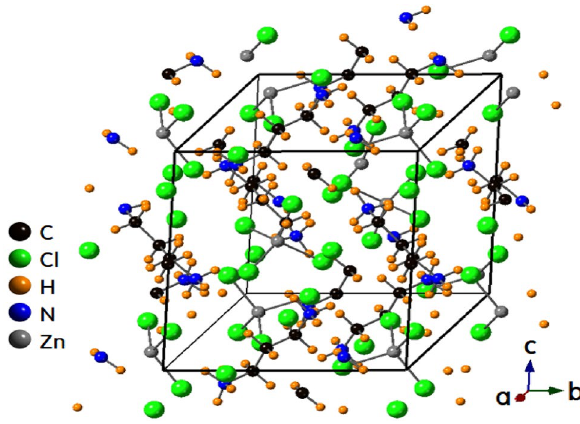
Figure 1. Crystal structure of [NH 3 (CH 2 ) 3 NH 3 ]ZnCl 4 at room